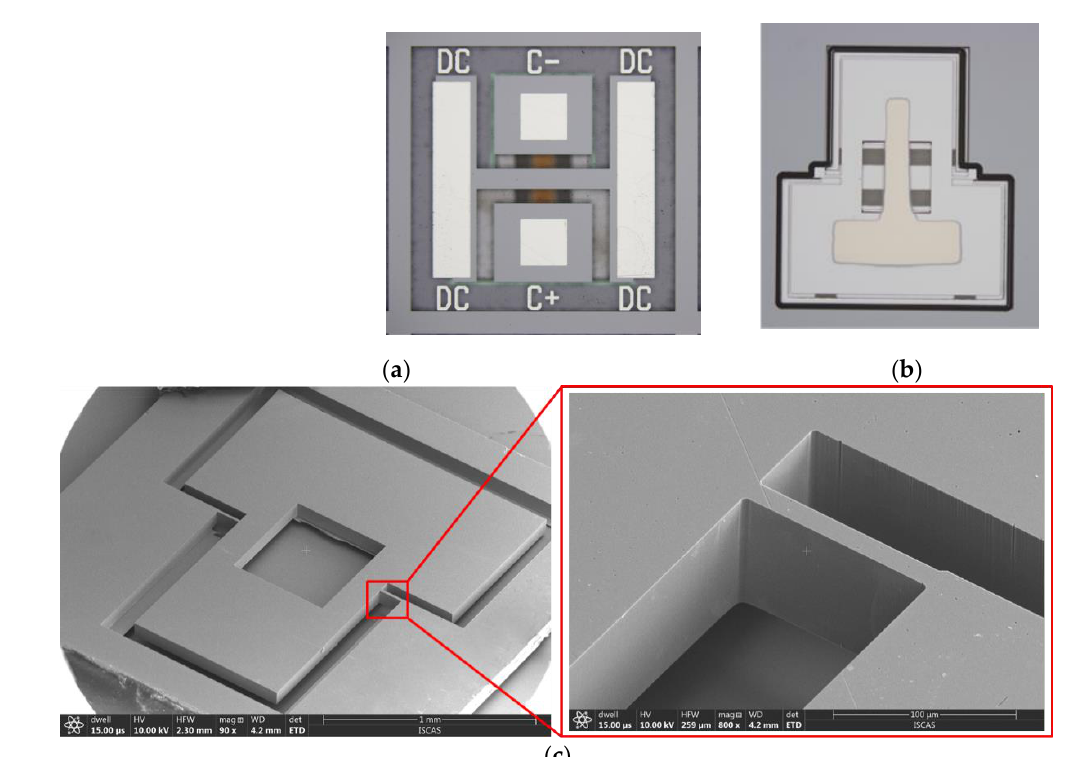
Figure 6. Pictures of the teeter-totter accelerometer. ( a ) Bottom side; ( b ) top side, ( c ) scanning electron microscopy (SEM) view of the mass and spring.